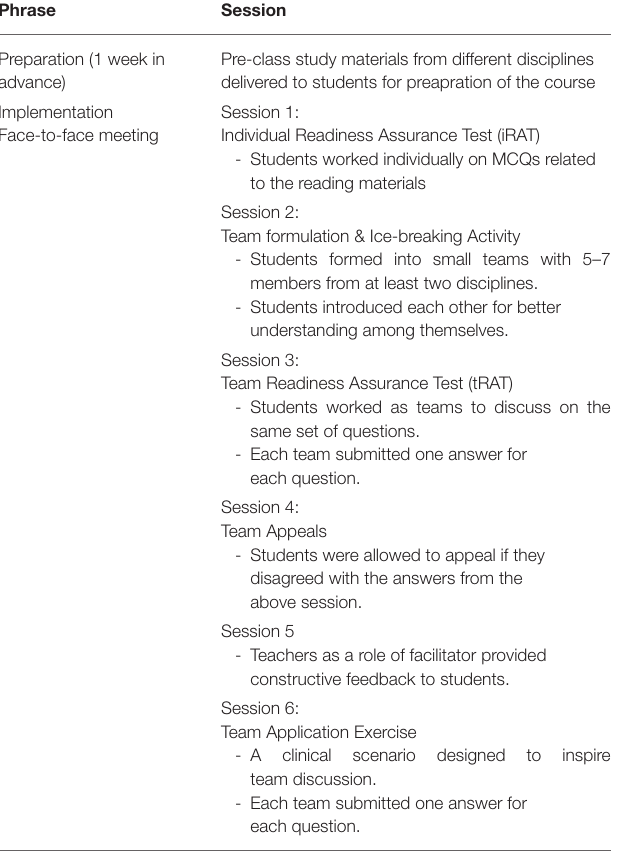
TABLE 2 | Design of the IPE course. Phrase